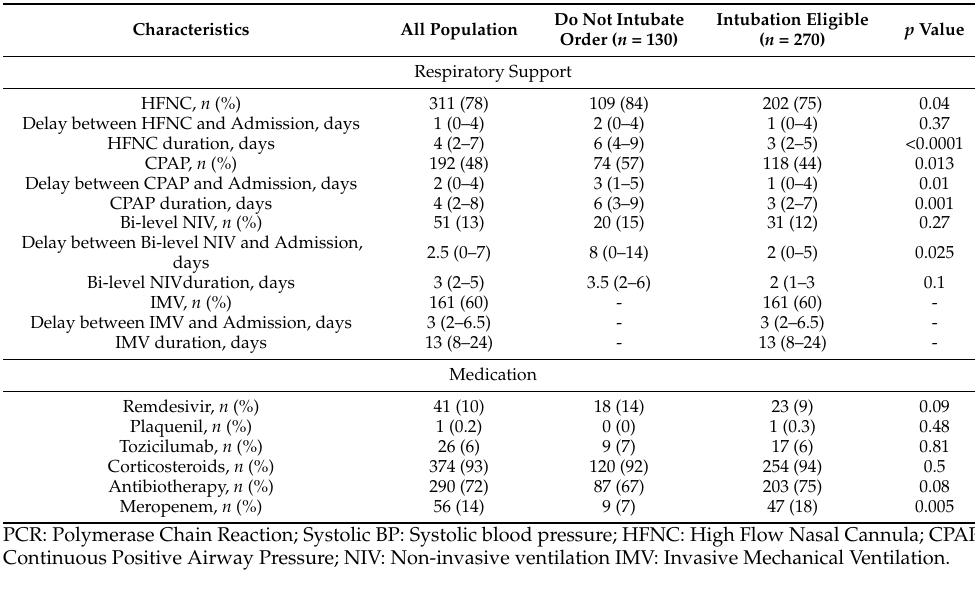
Figure 3. Characteristics of the patients before and after applying inverse probability of treatment weighting. Black Cater- pillar plot represents risk ratio to death before inverse probability of treatment weighting. Green caterpillar plot represents risk ratio to death after inverse probability of treatment weighting. BMI: Body Mass Index; HFNC: High Flow Nasal Can- nula; IPTW: Inverse Probability of Treatment Weighting; n : Number of patients; SD: Standardized Deviation. Factors associated with mortality are presented in Supplementary file (Figure S1). Risk ratio to death were higher for Older age, Chronic Heart Failure, Cancer and Neuro- logical pathology comorbidities (respectively, 1.05 (1.03 to 1.06); 1.59 (1.14 to 2.21); 1.68 (1.09 to 2.6) and 2.34 (1.5 to 3.64)). Use of HFNC at admission and PaO 2 /FiO 2 were associ- ated with lower mortality (respectively, 0.62 (0.45 to 0.86) and 0.90 (0.82 to 0.99)).